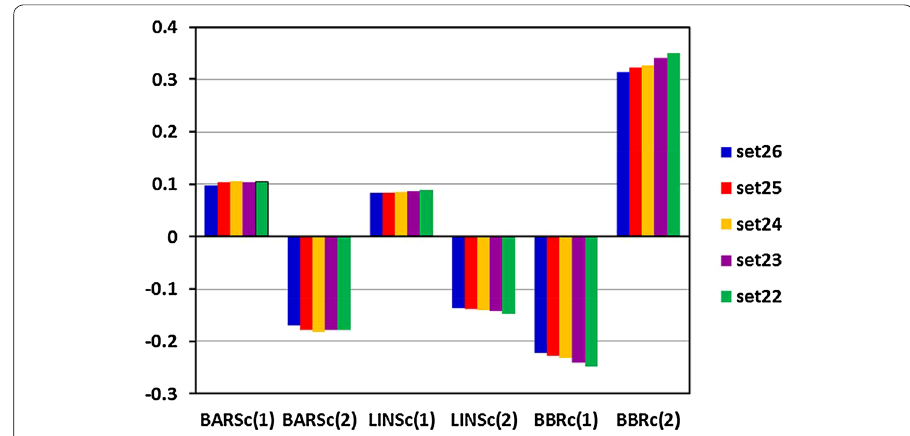
Fig. 2 Coefficient of variation for